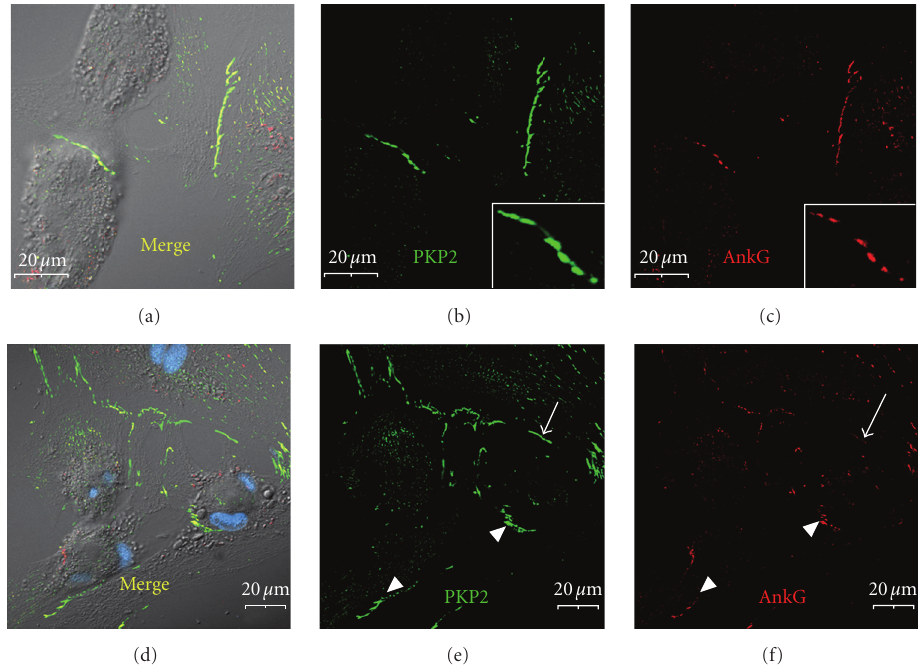
Figure 8: Ankyrin-G is selectively recruited to membrane domains involved in adhesive contacts. At 5 days post plating, ARCs were immunolabeled for PKP2 (green: a, b, d, e) and ankyrin-G (red: a, c, d, f). (a)–(c) Ankyrin-G localizes to mature cell adhesion domains where it co-localizes with PKP2 (see insets). (d)–(f) Ankyrin-G is far less abundant (arrowheads) or not yet detectable (arrow) in immature or newly-formed adhesive contacts. Scale bars are 20 μ m with the insets being 2 × magnifications of the larger image.